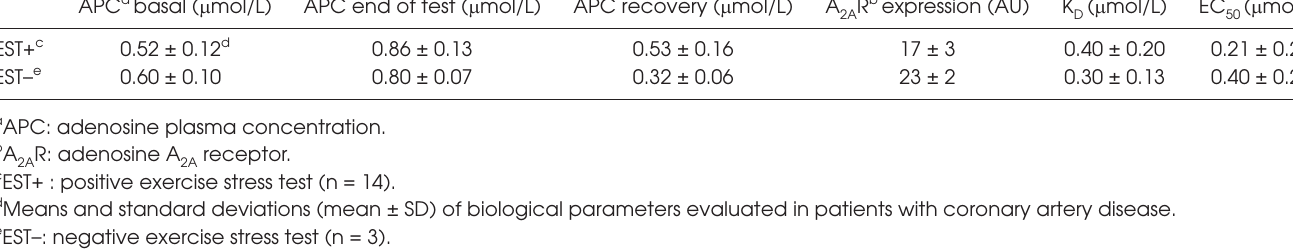
and EC were interpolated D 50